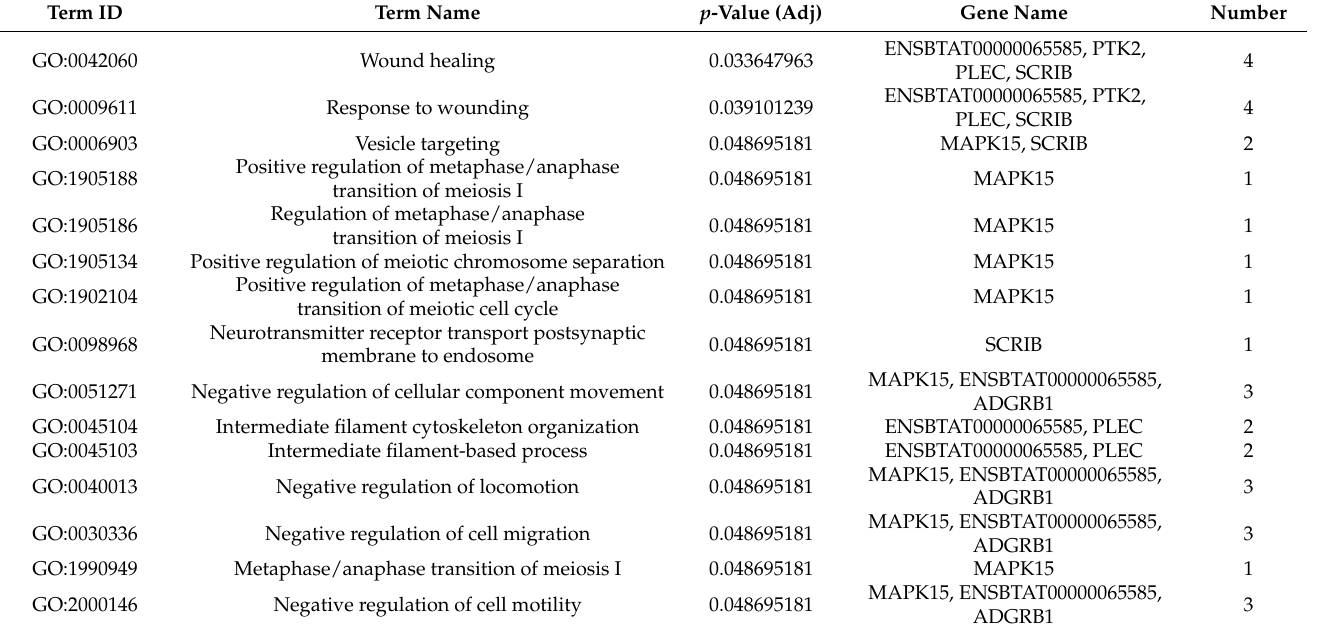
Table 3. Significant biological process associated with genes affecting milk yield.